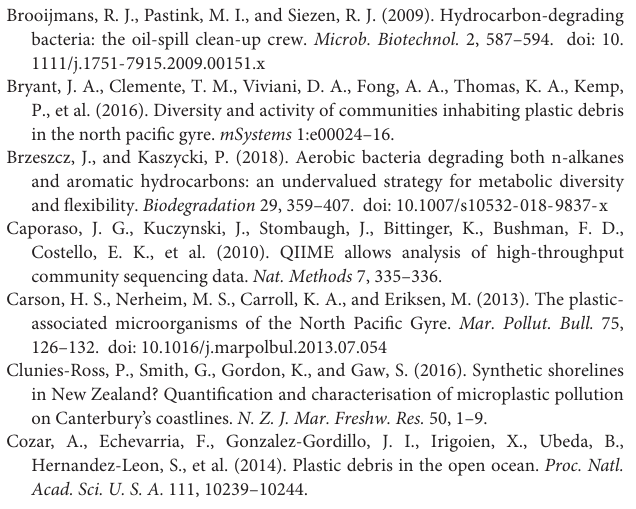
Supplementary Figure 2 | Direct visualisation of Planctomycetes and other bacteria on plastic particles using CARD-FISH and confocal laser scanning microscopy. (A) Planctomycetes were identified by probe Pla46 (shown in red). Numerous other microbes (probe EUB338-I, green; DAPI, blue) were detected. (B) DAPI stained cells (shown in blue), and Bacteria identified by probe EUB338-I (in green), Gammaproteobacteria identified by probe GAM42a (shown in red) and Planctomycetes were identified by probe Pla46 (shown in yellow). (C) Stained same as B on alternative plastic piece. All images where scanned as z -stack using